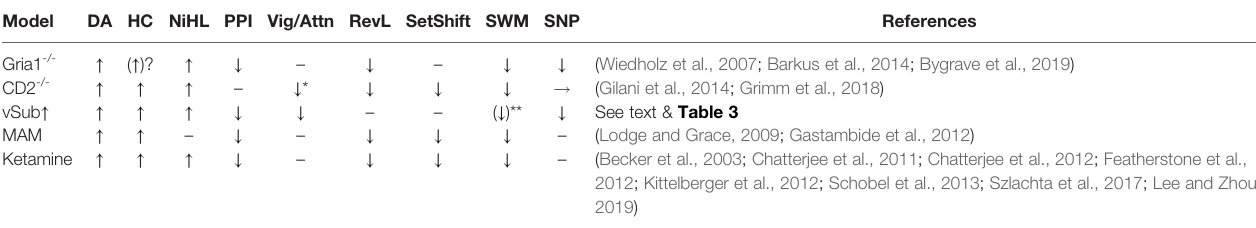
TABLE 4 | Rodent models with aberrant dopaminergic activity and salience attribution. Model